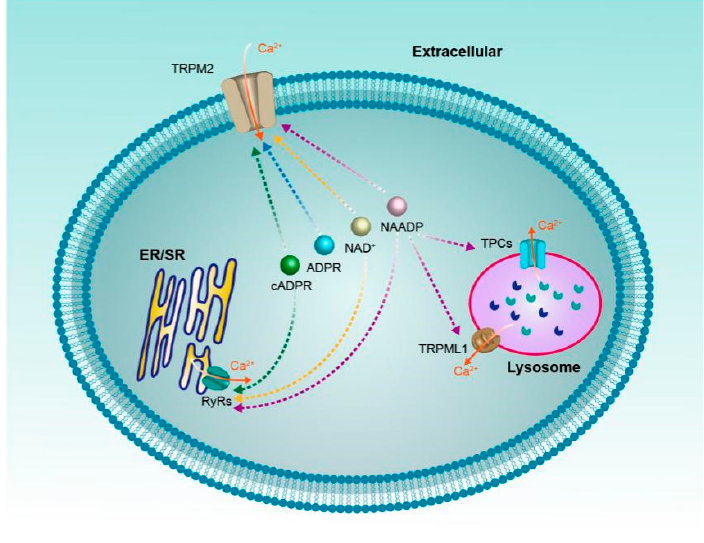
Figure 4. NAD + and its metabolites (ADPR, cADPR, NAADP) regulate calcium channels.